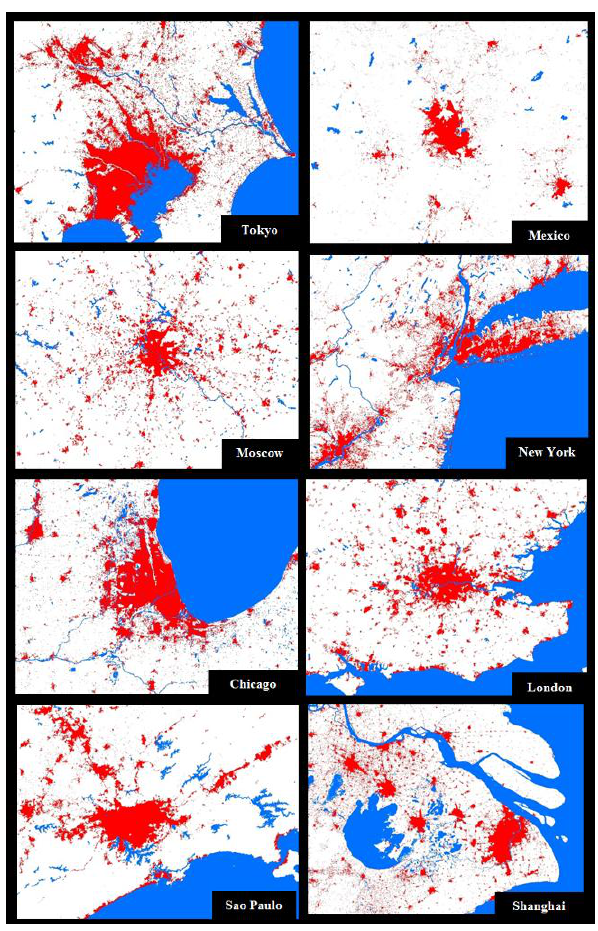
Figure 4.Mega-Cities Built up Area